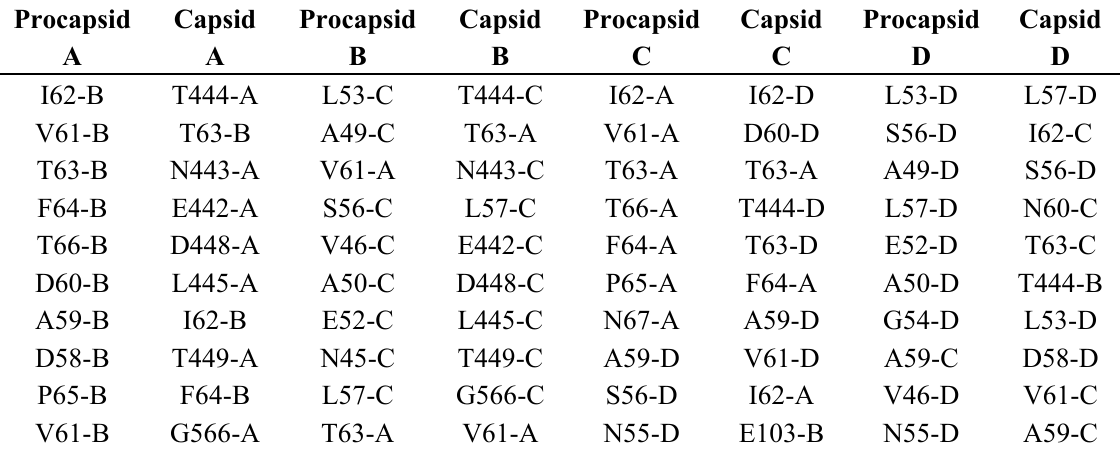
Table 1. Changes in the quaternary environment of N  V as a result of maturation. The ten closest amino acids from neighboring subunits are listed in order of distance (nearest distance listed first) for all subunits in both the procapsid and